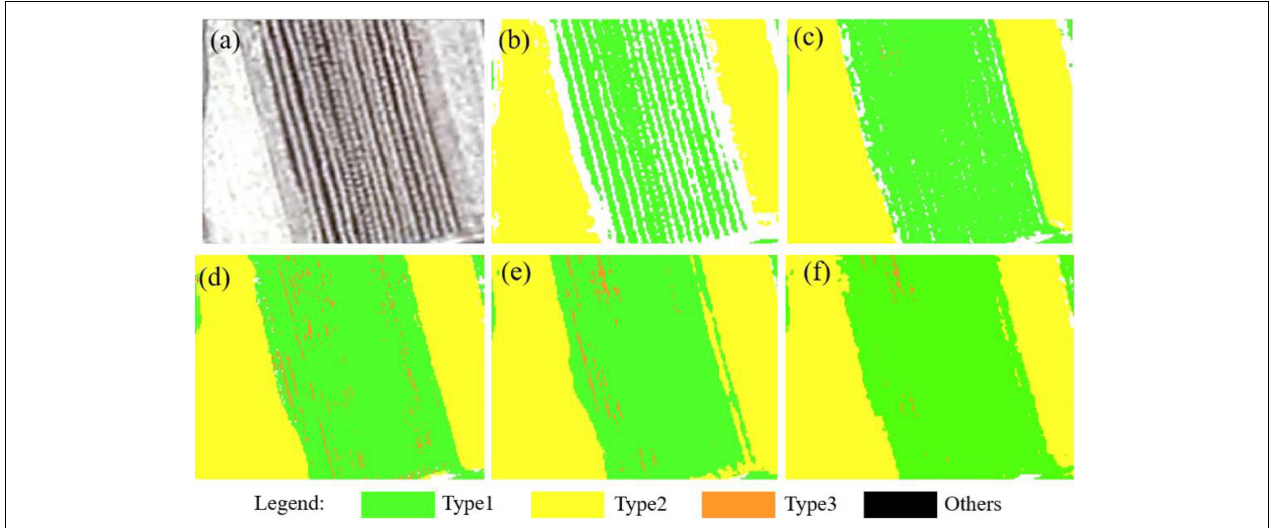
FIGURE 12 | The classification result of five methods. (a) The GF-2 PMS sub-image (R/B red , G/B green , and B/B blue ). (b–f) Correspond to the classification results of NB, RF, SVM, 1D-CNN, and 1D-CNN_CA using OID.